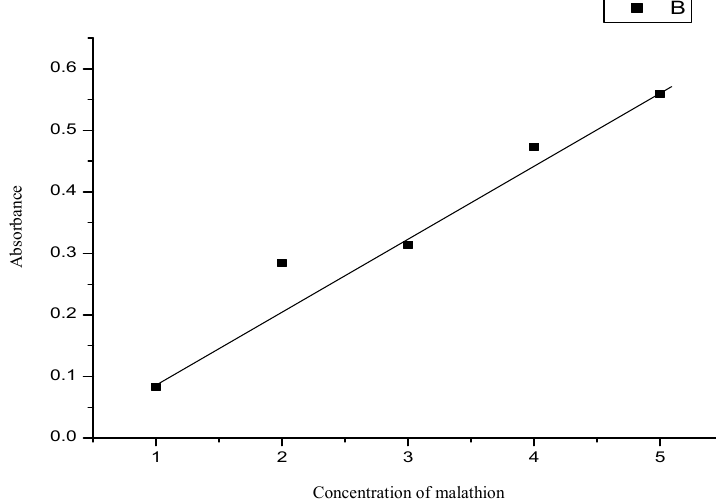
Figure 3. Absorbance versus concentration graph of